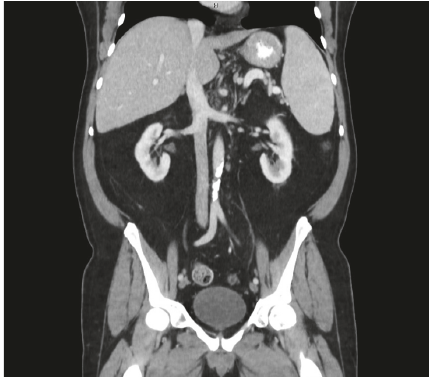
Figure 2: Posttreatment CT with contrast of the abdomen showing resolution of the enlarged intra-abdominal lymph nodes and reduc- tion in splenic